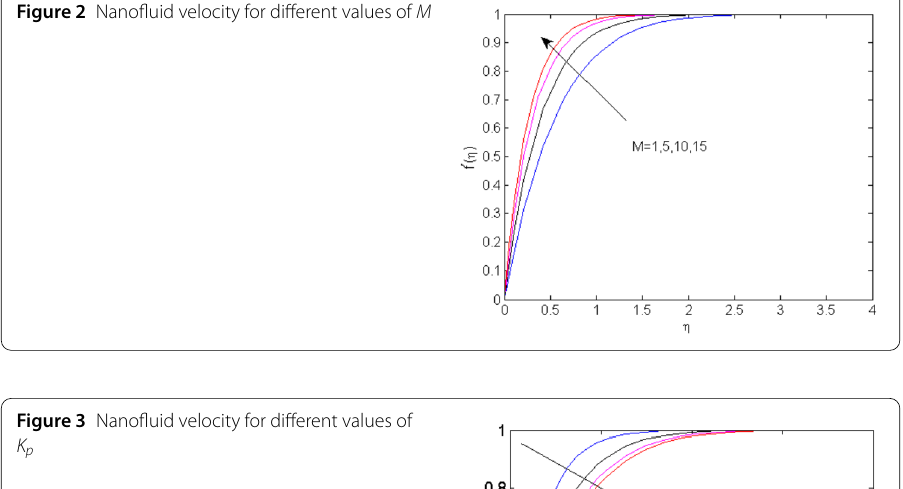
Figure 3 Nanofluid velocity for different values of K